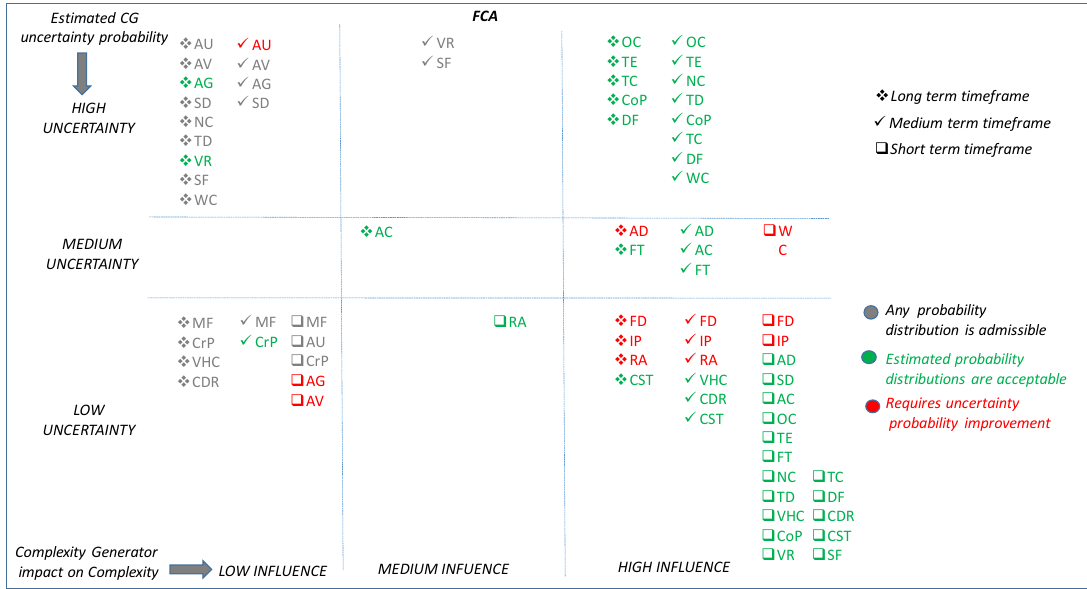
Figure 7. Overall situation for Complexity Generators. FCA application .